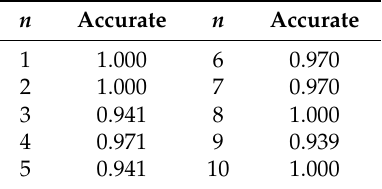
Table 6. Ten-fold cross-validation effect evaluation.